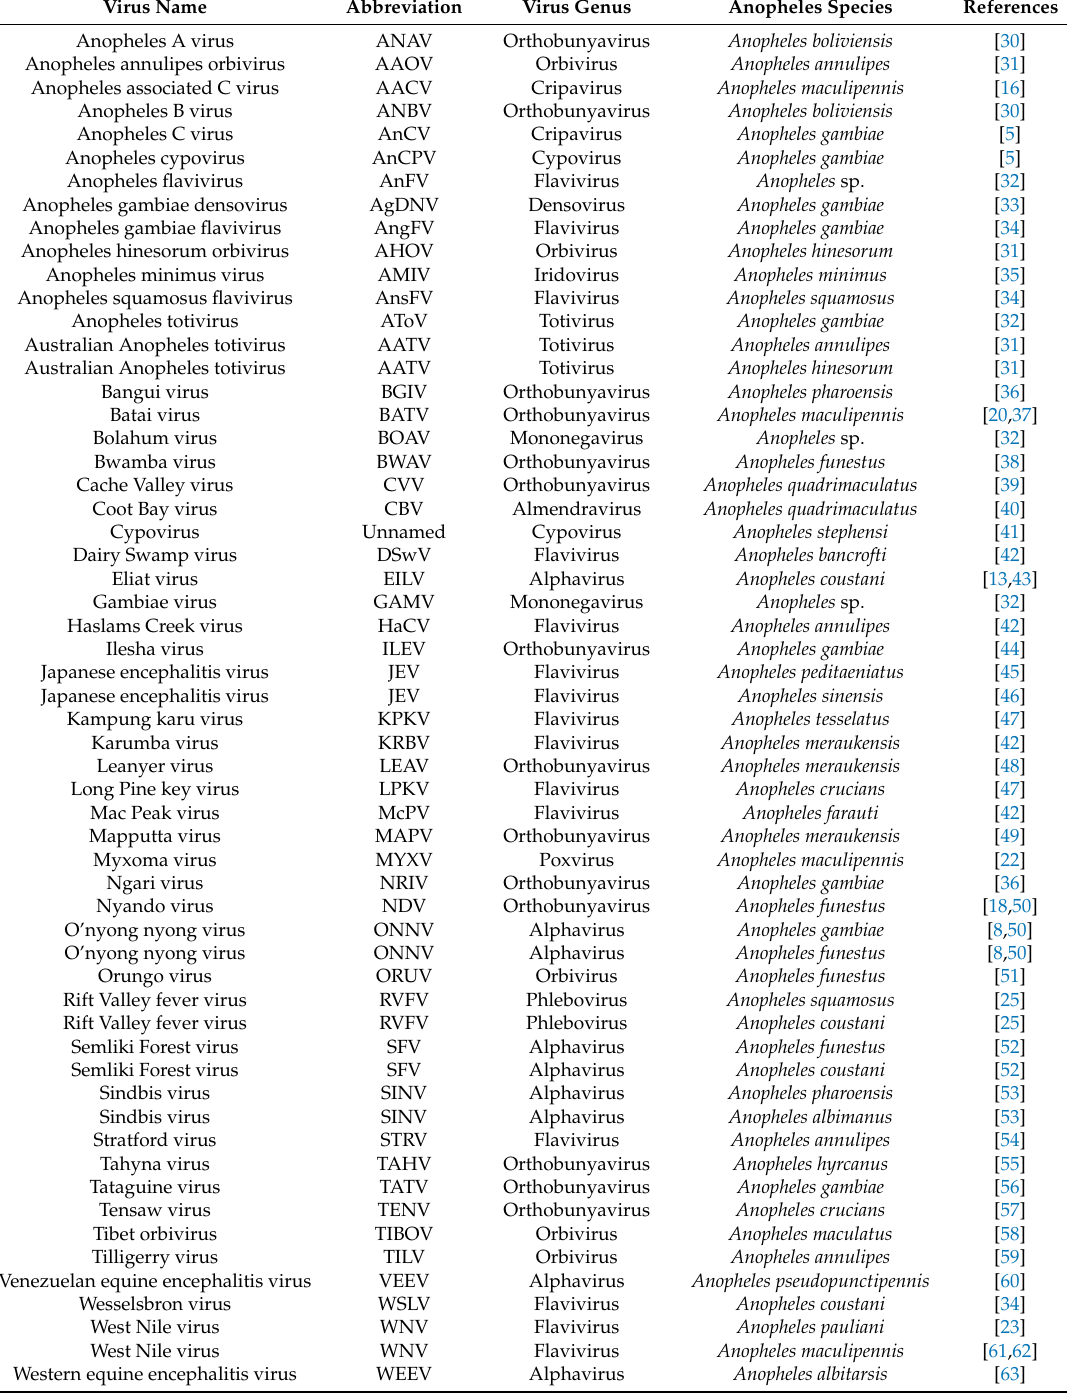
Table 1. Summary of reported Anopheles viruses with references. (Sortable Excel table available for download from Supplementary